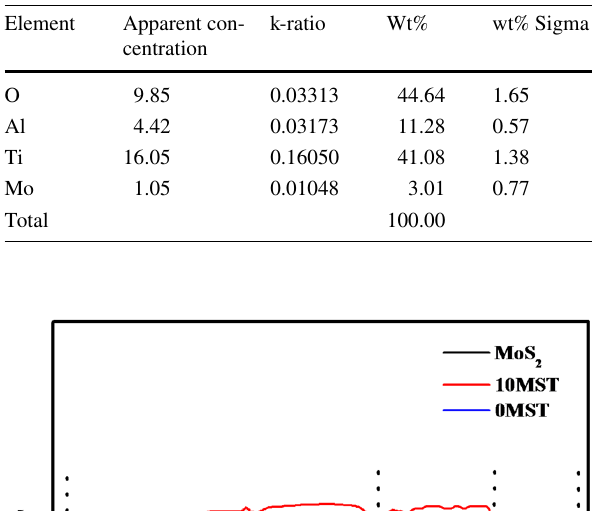
Fig. 6 PL spectral studies of 0 MST, 5 MST and 10 MST